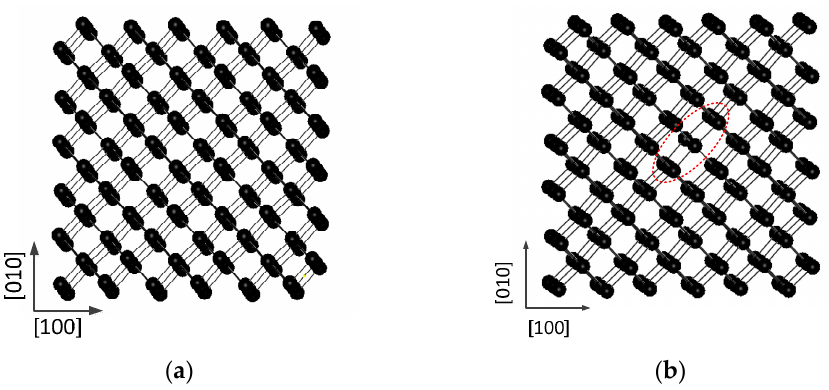
Figure 1. ( a ) Perfect Si lattice; ( b ) Si lattice with one vacancy.